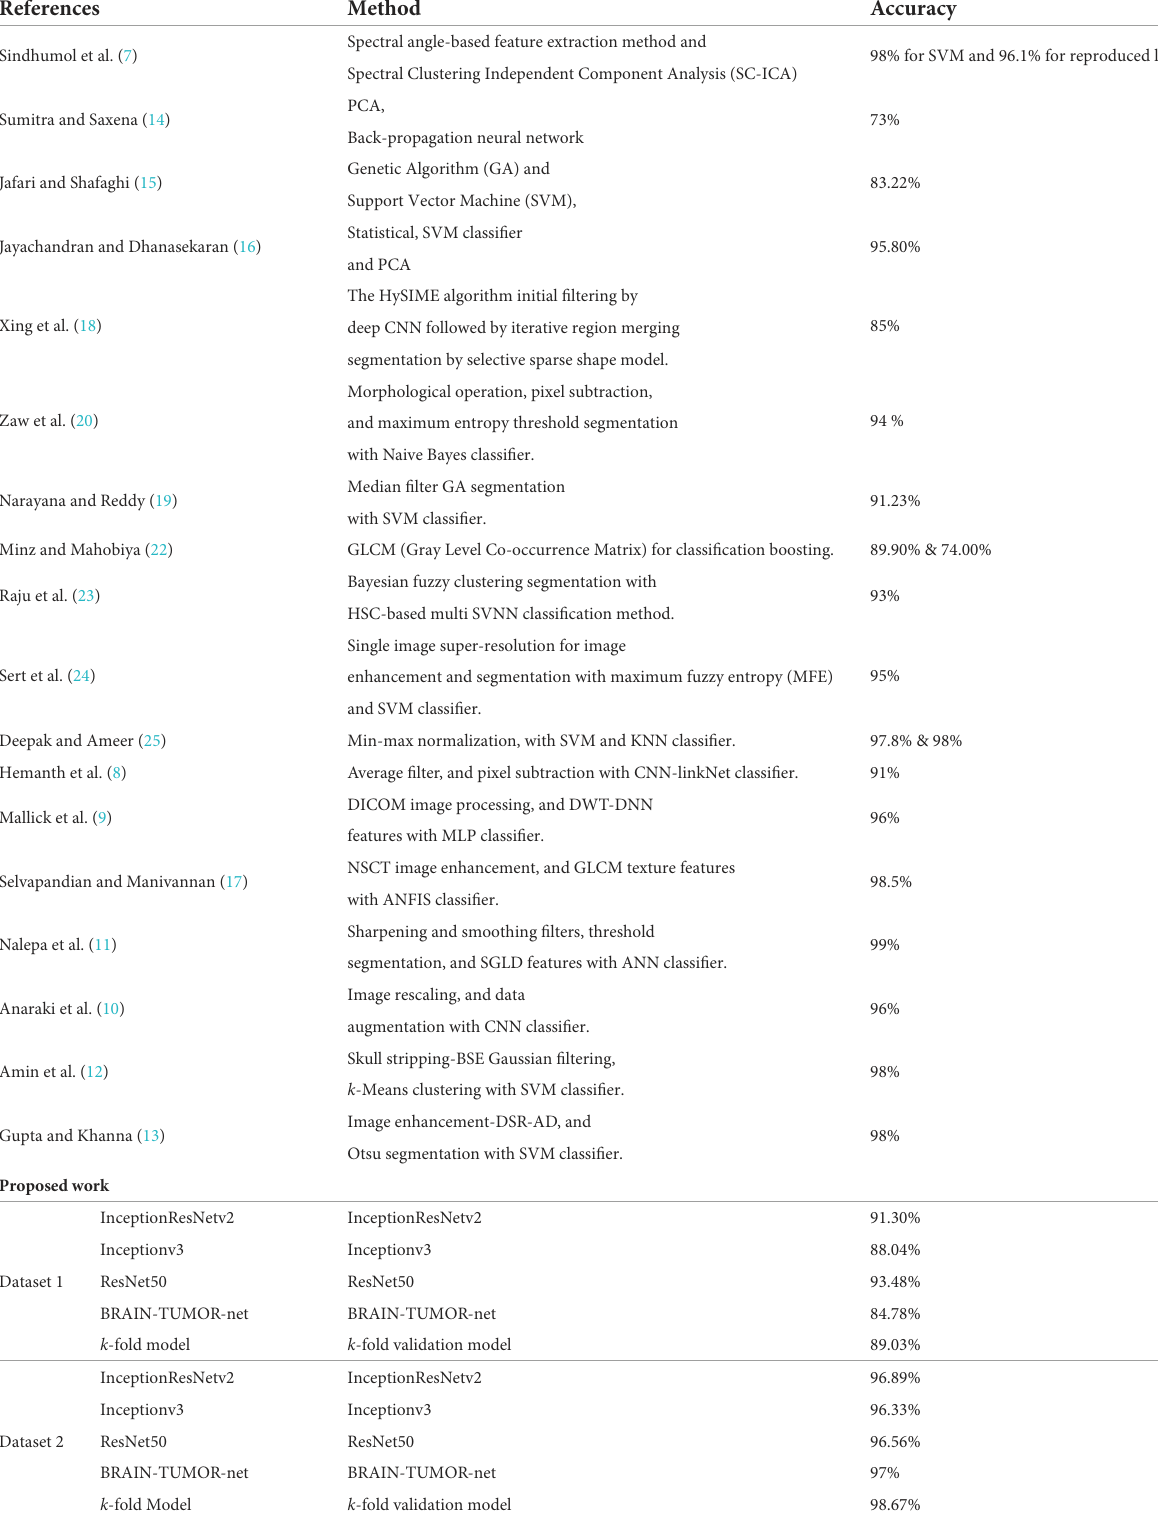
TABLE 6 Comparison of the proposed work with state-of-the-art